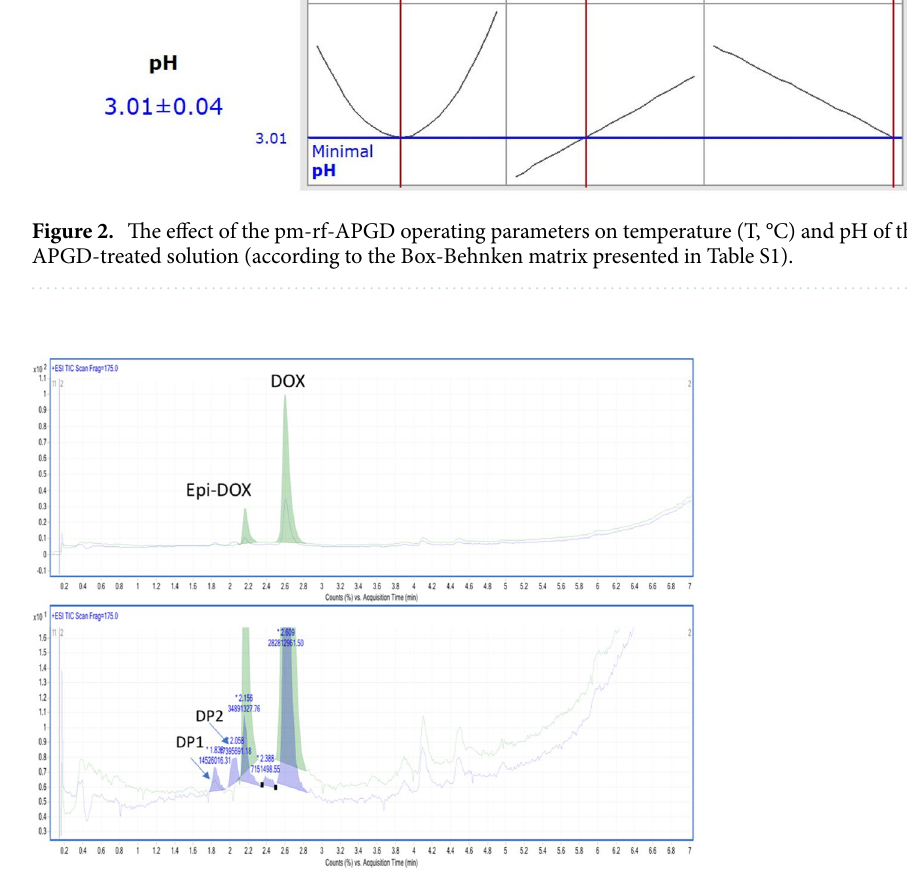
Figure 3. The upper part—the total ion current chromatogram (TIC) of DOX (the untreated solution); the lower part—the corresponding TIC with the added chromatogram of the pm-rf-APGD-treated DOX